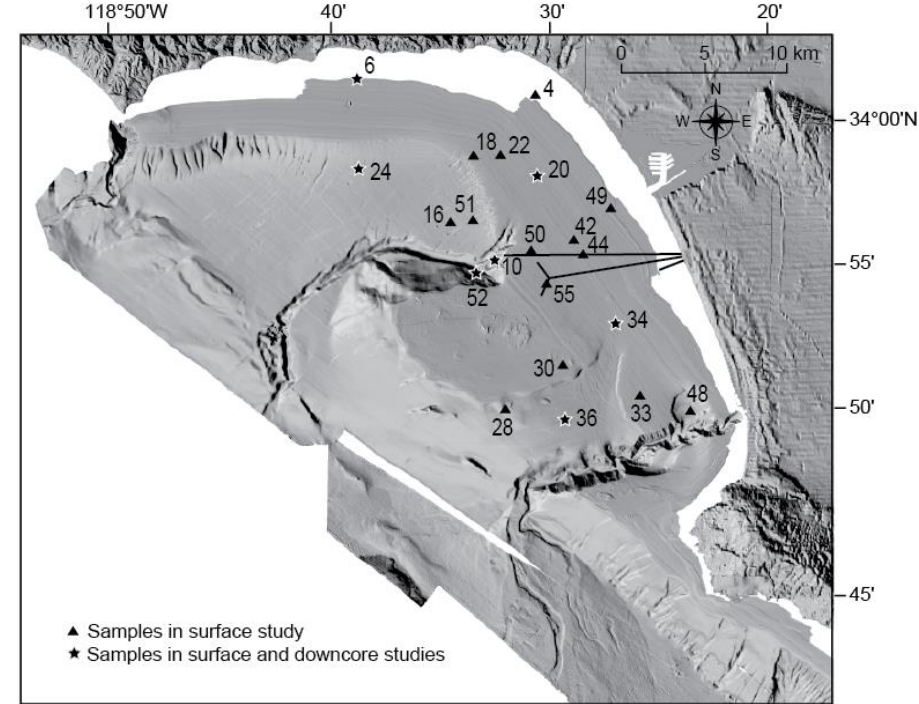
Figure 2 Figure 2. Side-scan sonar image of Santa Monica Bay, showing the location of the 21 foraminiferal sample sites obtained in 1997 and the 7-Mile, 5-Mile, and 1-Mile outfalls. Table 1. Metadata (core number, latitude, longitude, and water depth) for the 21 sampling sites used in this study from USGS Cruise